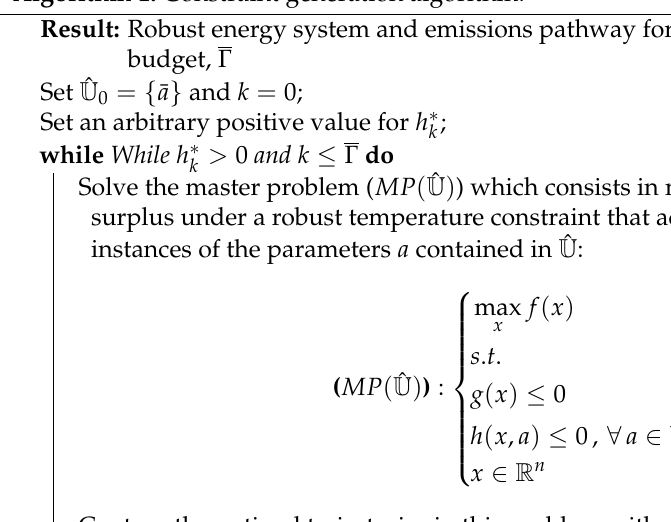
Algorithm 1: Constraint generation